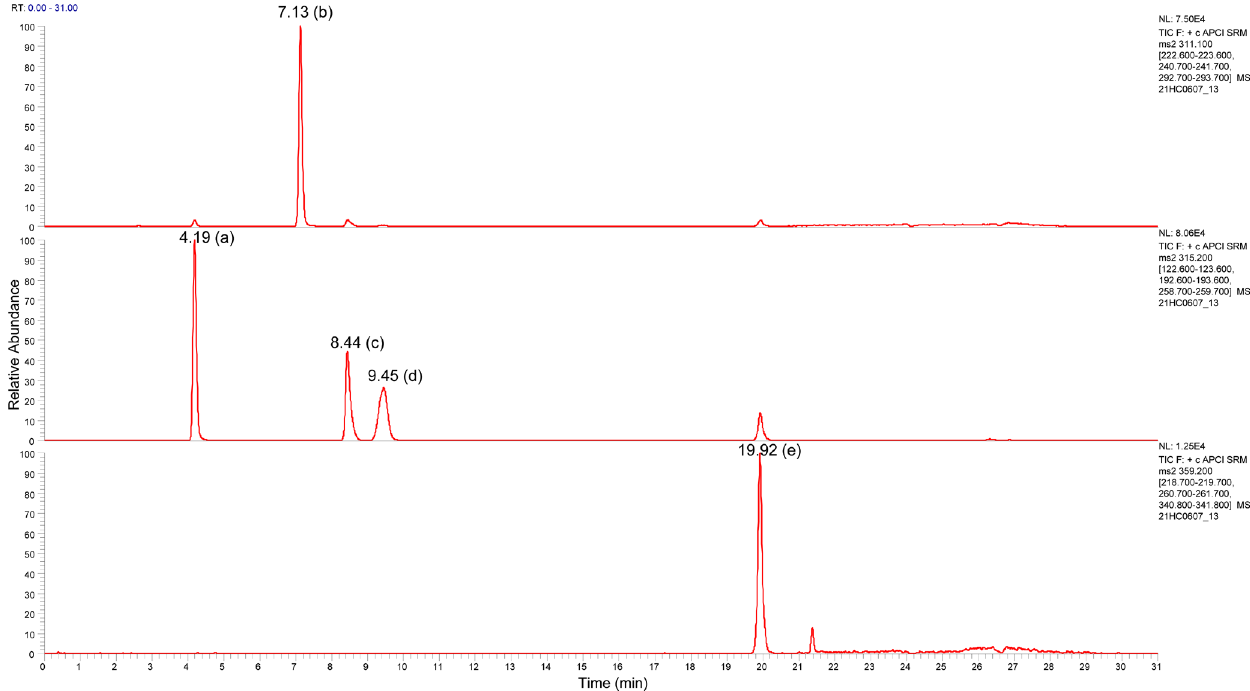
Figure 1. Typical liquid chromatography-tandem mass spectrometry chromatogram of a cannabinoid mixture showing the separation between CBD (a), CBN (b), Δ 9 -THC (c), Δ 8 -THC (d) and THCA (e) (concentration 200 µg/L; analytical conditions see Ref.